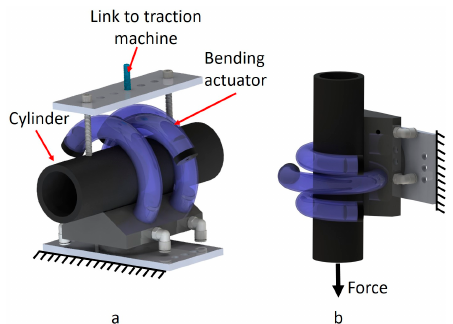
Figure 9. Experimental set-ups ( a ) to measure gripping payload, using a TAXT Plus Texture Analyzer (traction machine) (Stable Micro Systems, Godalming, Surrey, UK) with a 50 kg load cell and ( b ) to measure the pull-out force using free weights. Bending actuators are shown without their